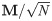
Spectrum of the matrix M/N for inhibitory rate models with g(x) = x
γ
H(x).A-B: γ = 1. The matrix was diagonalized numerically for N = 10000, K = 400, I
0 = 1 and different values of J
0. A: The bulk of the spectrum (one realization). Left panel: Imaginary vs. real parts of the eigenvalues for one realization of M. Blue: J
0 = 2.045. Red: J
0 = 0.307. Right panel: Histograms (100 realizations) of N
eig/R where N
eig is the number of eigenvalues with modulus between R and R+ΔR (ΔR = 0.0479 (top), 0.0122 (bottom)) for J
0 = 2.045 (top) and J
0 = 0.307 (bottom). The eigenvalues are almost uniformly distributed throughout the disk of radius λ
max (except very close to the boundary). B: The largest real part of the eigenvalues, λ
max (one realization, black dots) is compared with the conjecture Eq (7) (solid line). C,D: Same as in A, B, for γ = 0.55. Blue: J
0 = 3.01, ΔR = 0.0491; red: J
0 = 0.75, ΔR = 0.0246 (red). The agreement with Eq (7) is good for J
0 not too large but the eigenvalues distribution is non-uniform. Quantitatively similar results are found for N = 20000, K = 400 as well as N = 40000, K = 600 (not shown).